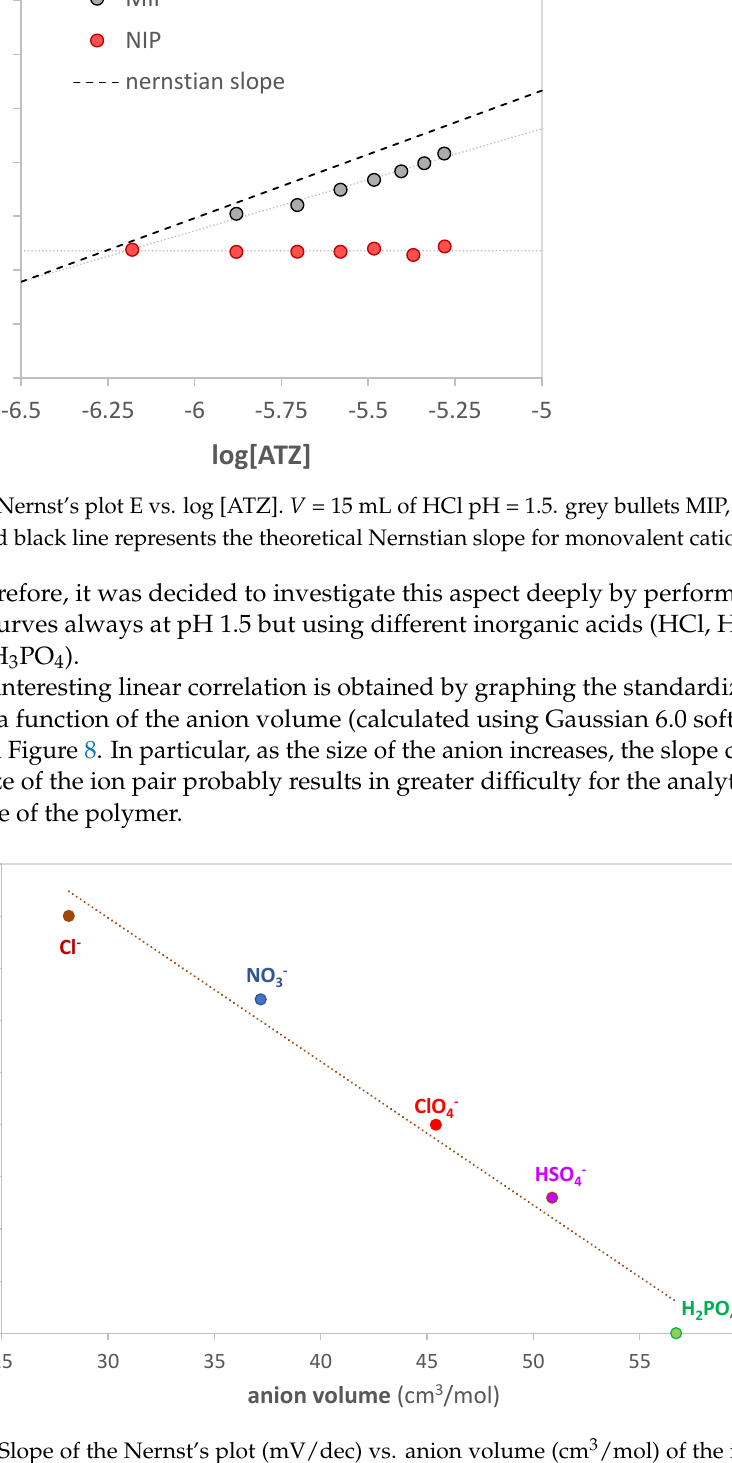
Figure 8. Slope of the Nernst’s plot (mV/dec) vs. anion volume (cm 3 /mol) of the inorganic acids used as the ionic medium. Anion volume computed with Gaussian 6.0 software [68].